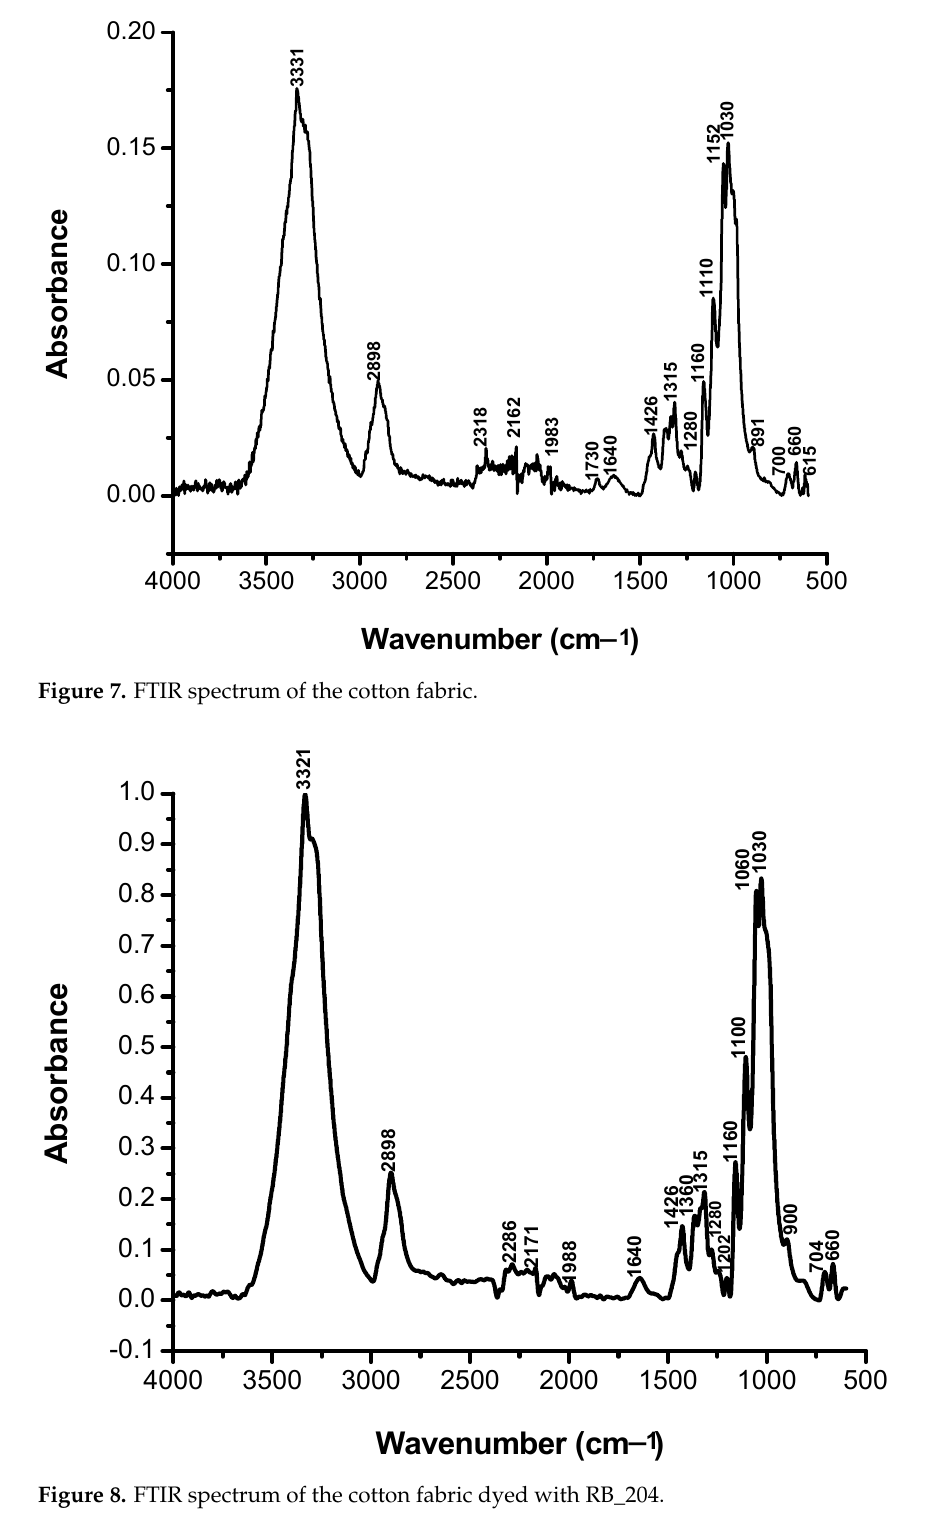
(a)(b) Figure 6 . UV-Vis absorption spectra of RB_204 dye: ( a ) non-irradiated; ( b ) irradiated 100 h . The reduction of absorption (hypochromic effect) and the bathocrom displacement of the peak towards higher wavelength values (from 614 to 621 nm) was observed. Hypochromic modification of the UV spectrum after irradiation may be a consequence of partial destruction of the dye structure action, while bathochrome modification supports the extension of the conjugate double bonds system. Literature reports correlate the darkening of dyes with complex photo–oxidation phenomena, leading to the formation of cromophores [19,24]. The de- crease in L* values may be correlated with amine entities number and substitution degree also explaining the slight bathochrome deplacement effect and green and yellow cromophore accumulation. The hypochrome effect is generated by aromatic ring disrup- tion [19,25].